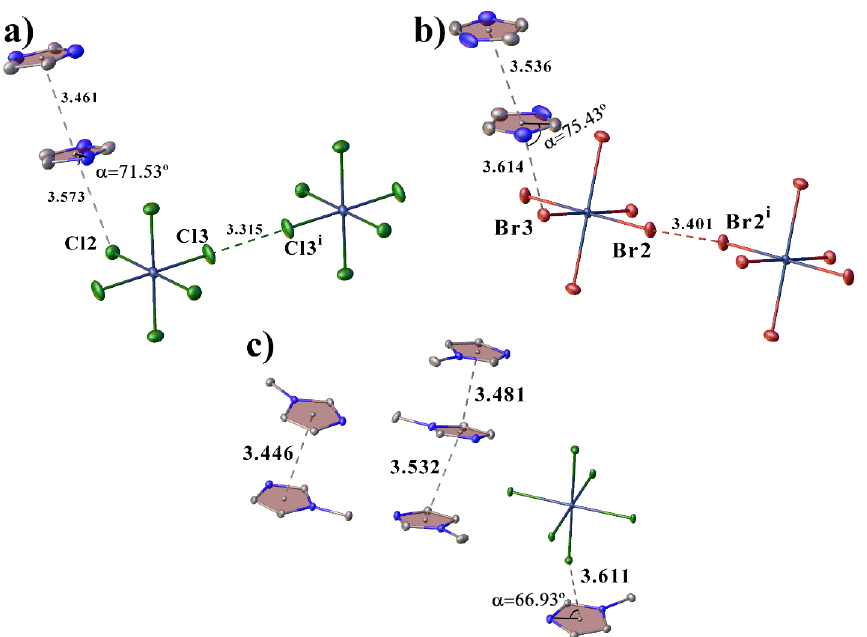
Figure 6. View showing halogen bonds, anion– π and π –stacking interactions in the structures VI (a) , VII (b) and VIII (c) .